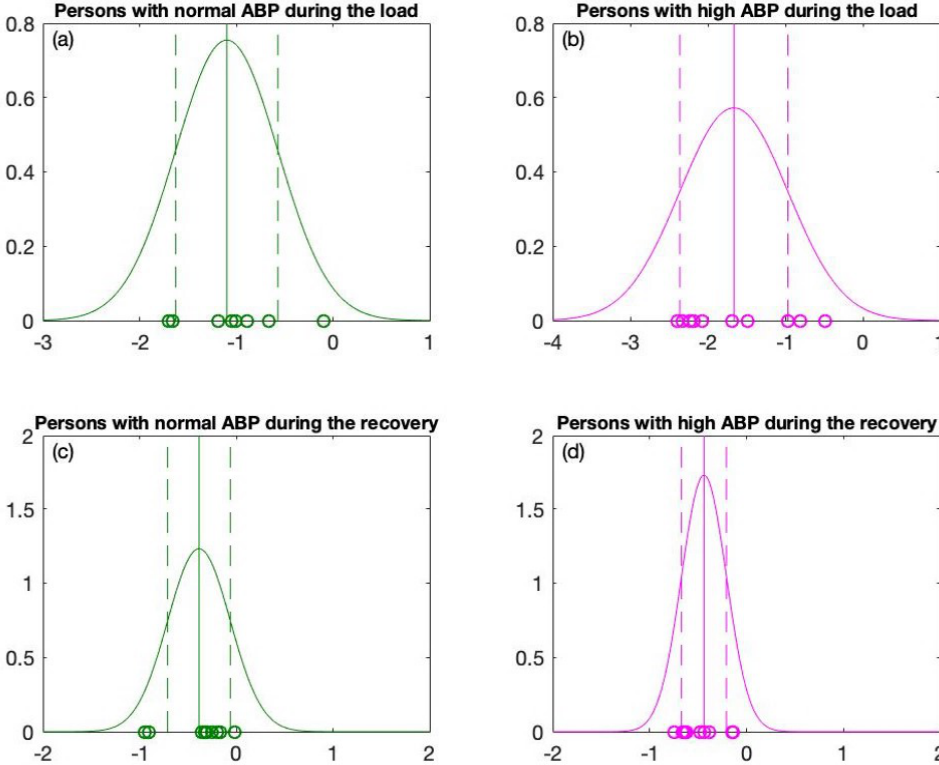
Figure 6. The Gaussian distribution graphs for ( a ) Persons with normal ABP during the load. ( b ) Persons with high ABP during the load. ( c ) Persons with normal ABP during the recovery and ( d ) Persons with high ABP during the